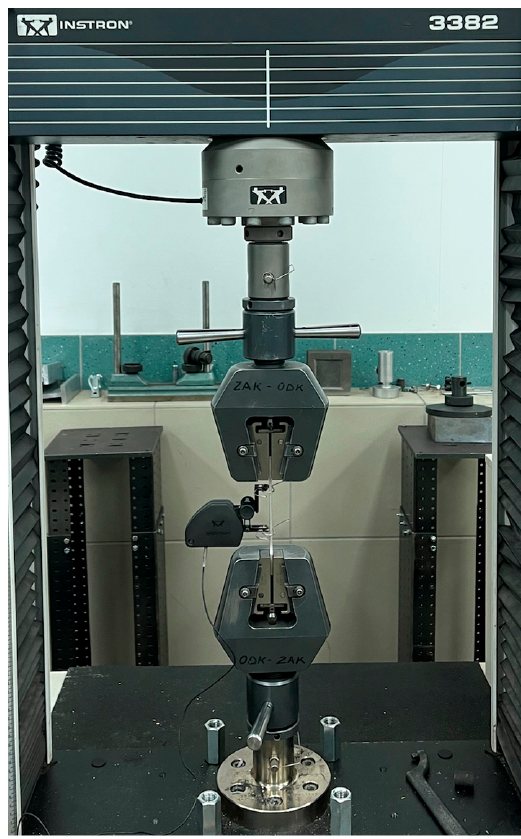
Figure 7. Sample during tests carried out on the Instron 3382 machine in Warsaw at WUT. The machine was made in the USA.